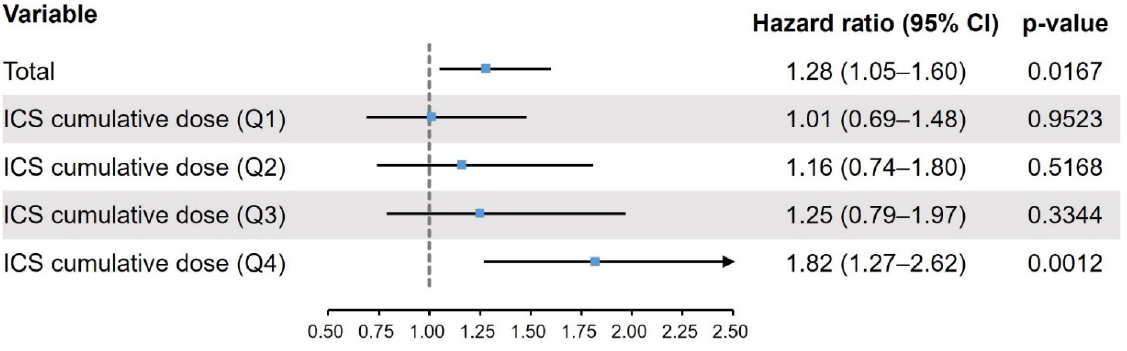
Figure 2. Risk of tuberculosis in fluticasone propionate users compared with budesonide users. Hazard ratios were calculated as the ratio of the risk of tuberculosis in fluticasone propionate compared with budesonide (reference) within identical doses and are presented with 95% CIs and p ‐ values. CI, confidence interval; ICS, inhaled corticosteroid.